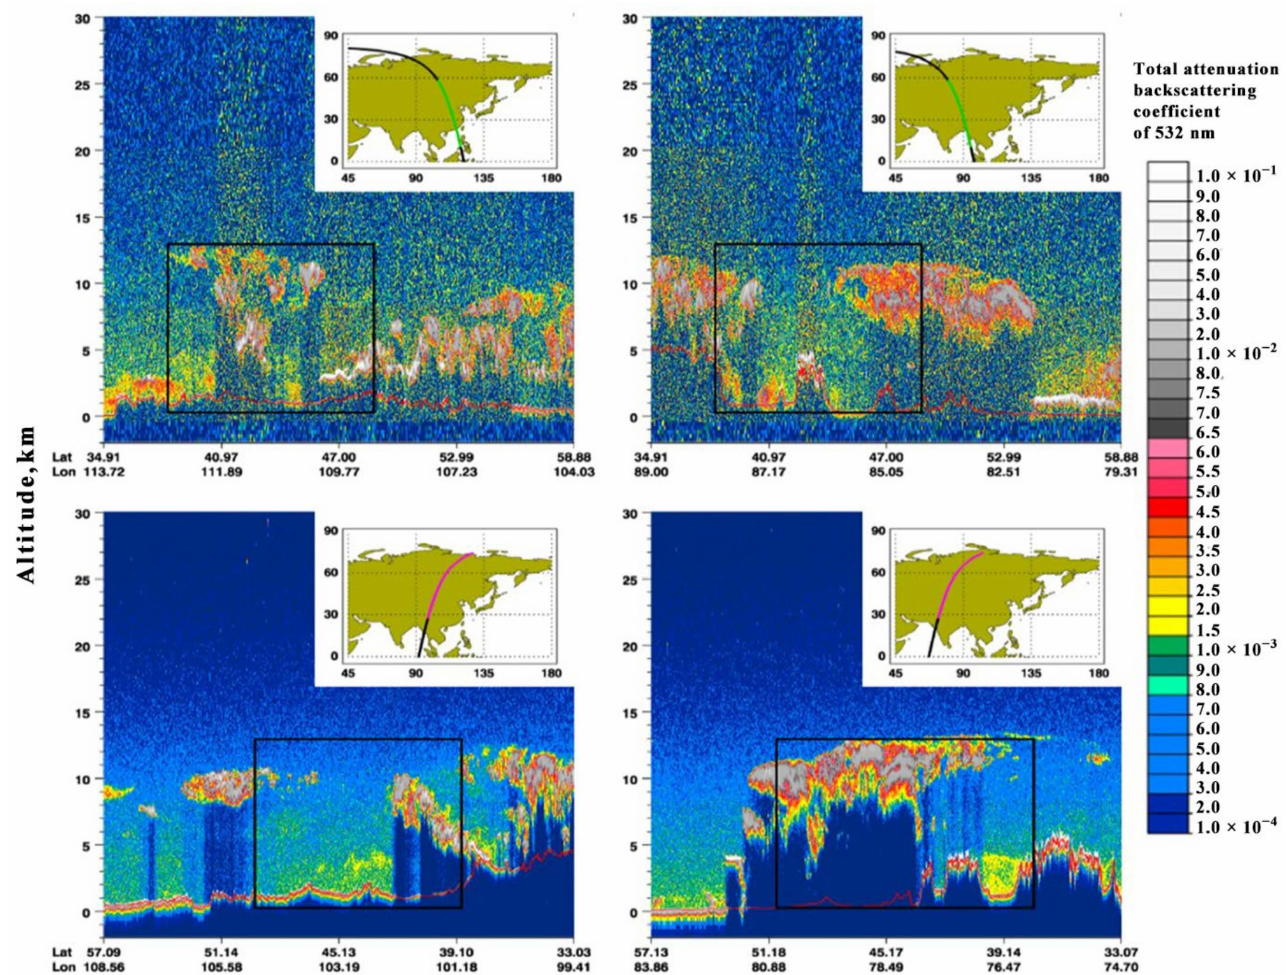
Figure 6. Total attenuation backscattering coefficient of 532 nm obtained by CALIPSO for the period relevant to the sandstorm event in April 2018, for the case study